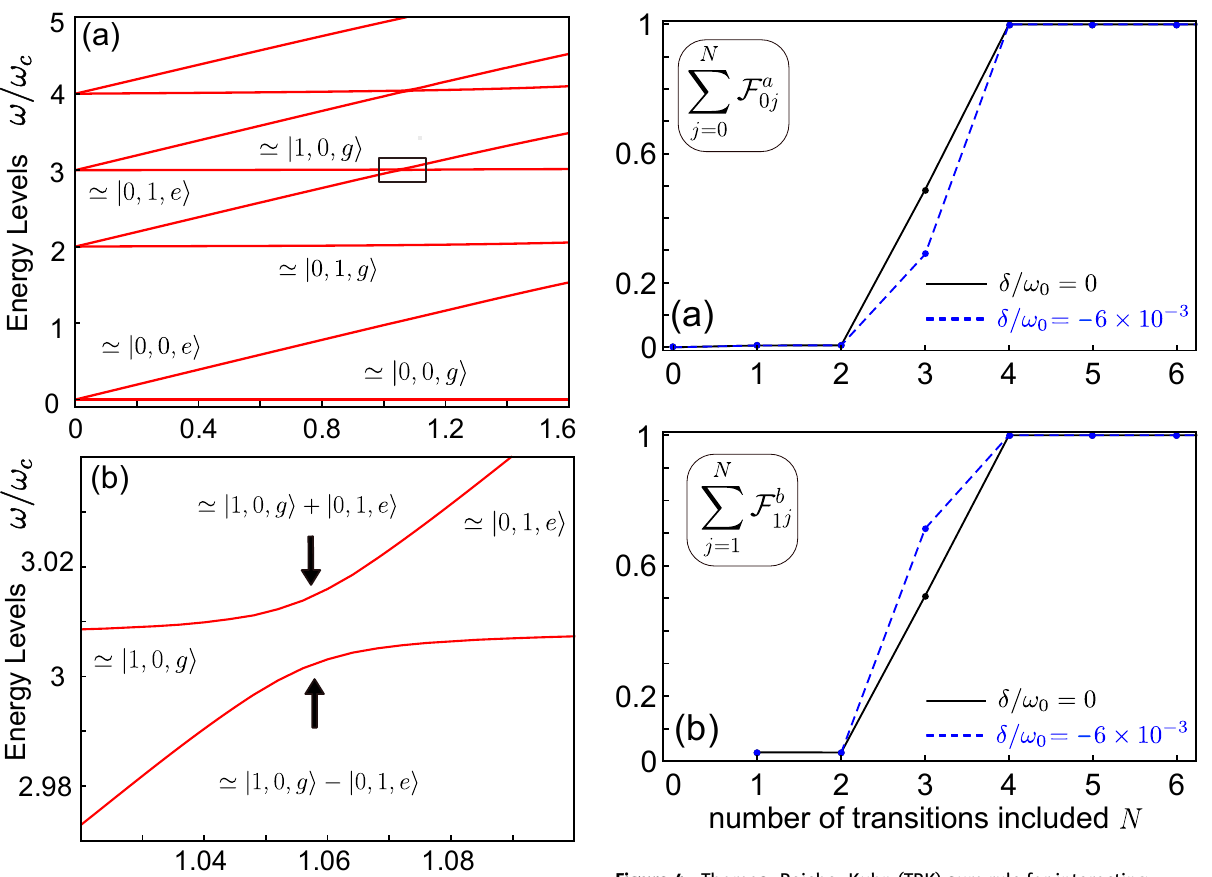
Figure 4: Thomas – Reiche – Kuhn (TRK) sum rule for interacting photons in the three-component system described by the Hamilto- nian in